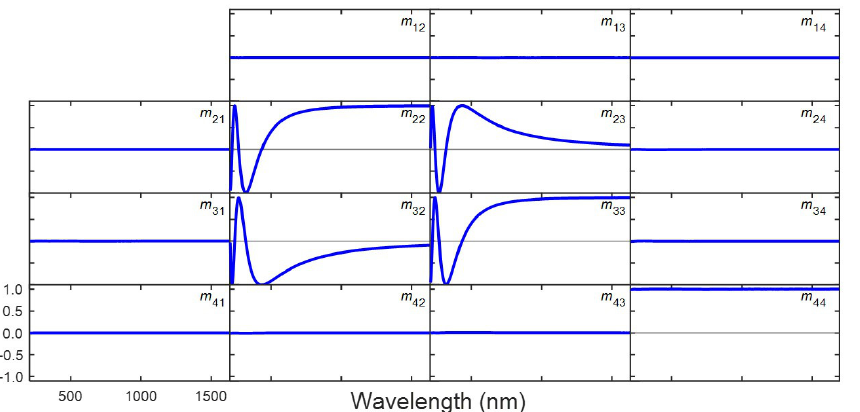
Figure 4. The transmission Mueller matrix of an α -cut quartz